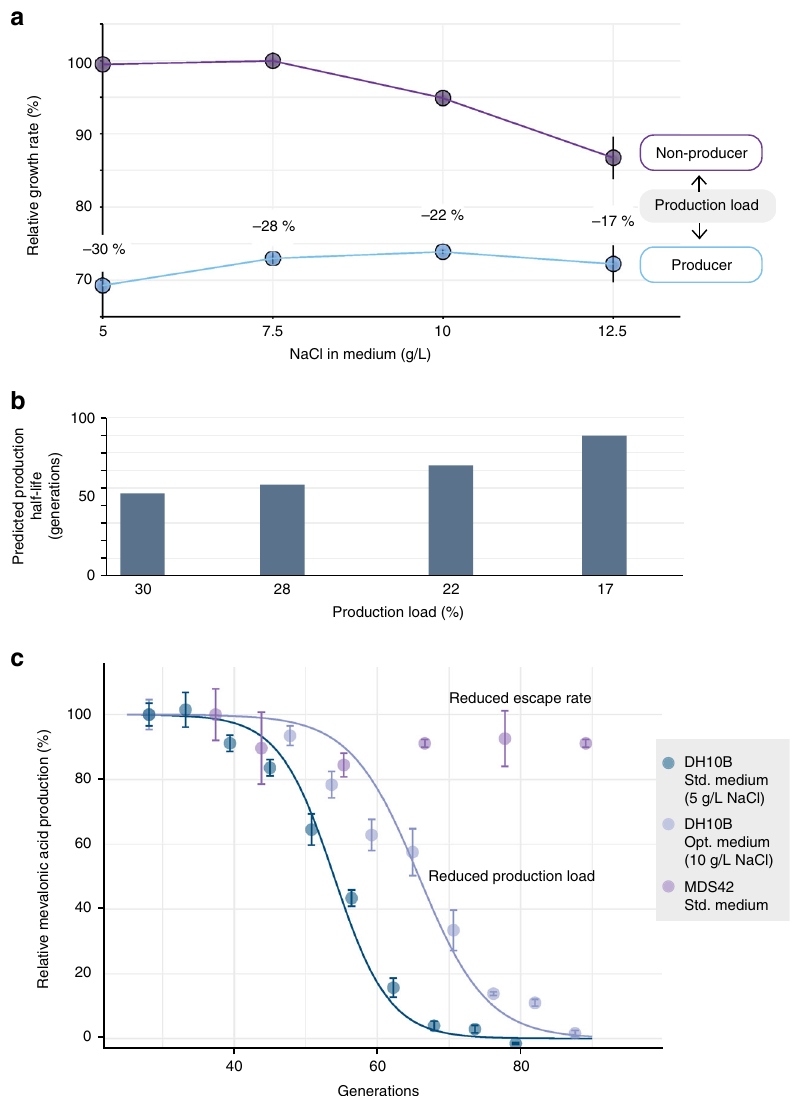
Fig. 5 Reducing production decline by optimization of spontaneous escape rate and production load. a Limiting the production load of mevalonic acid production by supplementing medium with elevated NaCl concentrations (i.e., minimizing the growth advantage of mutation). This reduction is evident by the growth rate difference of pure producing and non-producing populations. Growth rates depicted relative to fastest growing condition and production load calculated as relative growth rate difference. Error bars depict s.e.m. ( n = 6). b Predicted half-life of a producing cell population with a 2.1 × 10 – 7